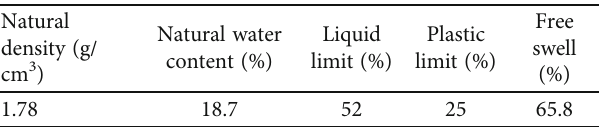
Table 2: Properties of SLS solution used in this research. Water Density Property (%) (g/cm 3 )